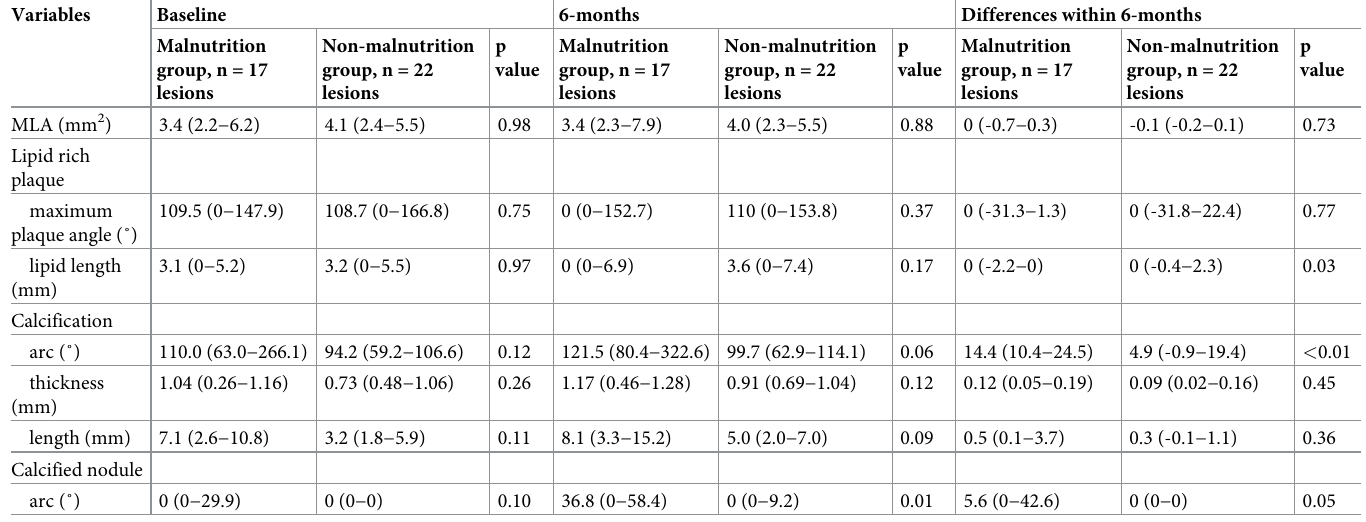
Table 5. OCT findings of non-culprit